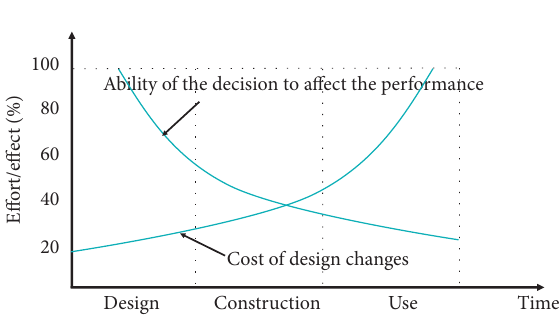
Figure 2: Life cycle stage and its influence on